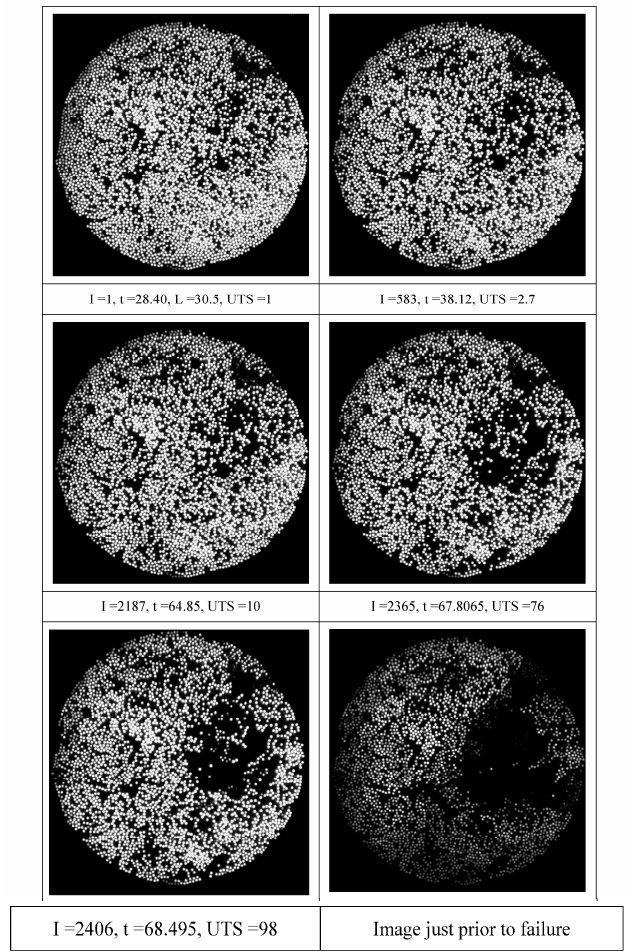
Figure 9. Summary of tensile test and in-situ monitoring of light attenuation characteristics for the SDOF composites.